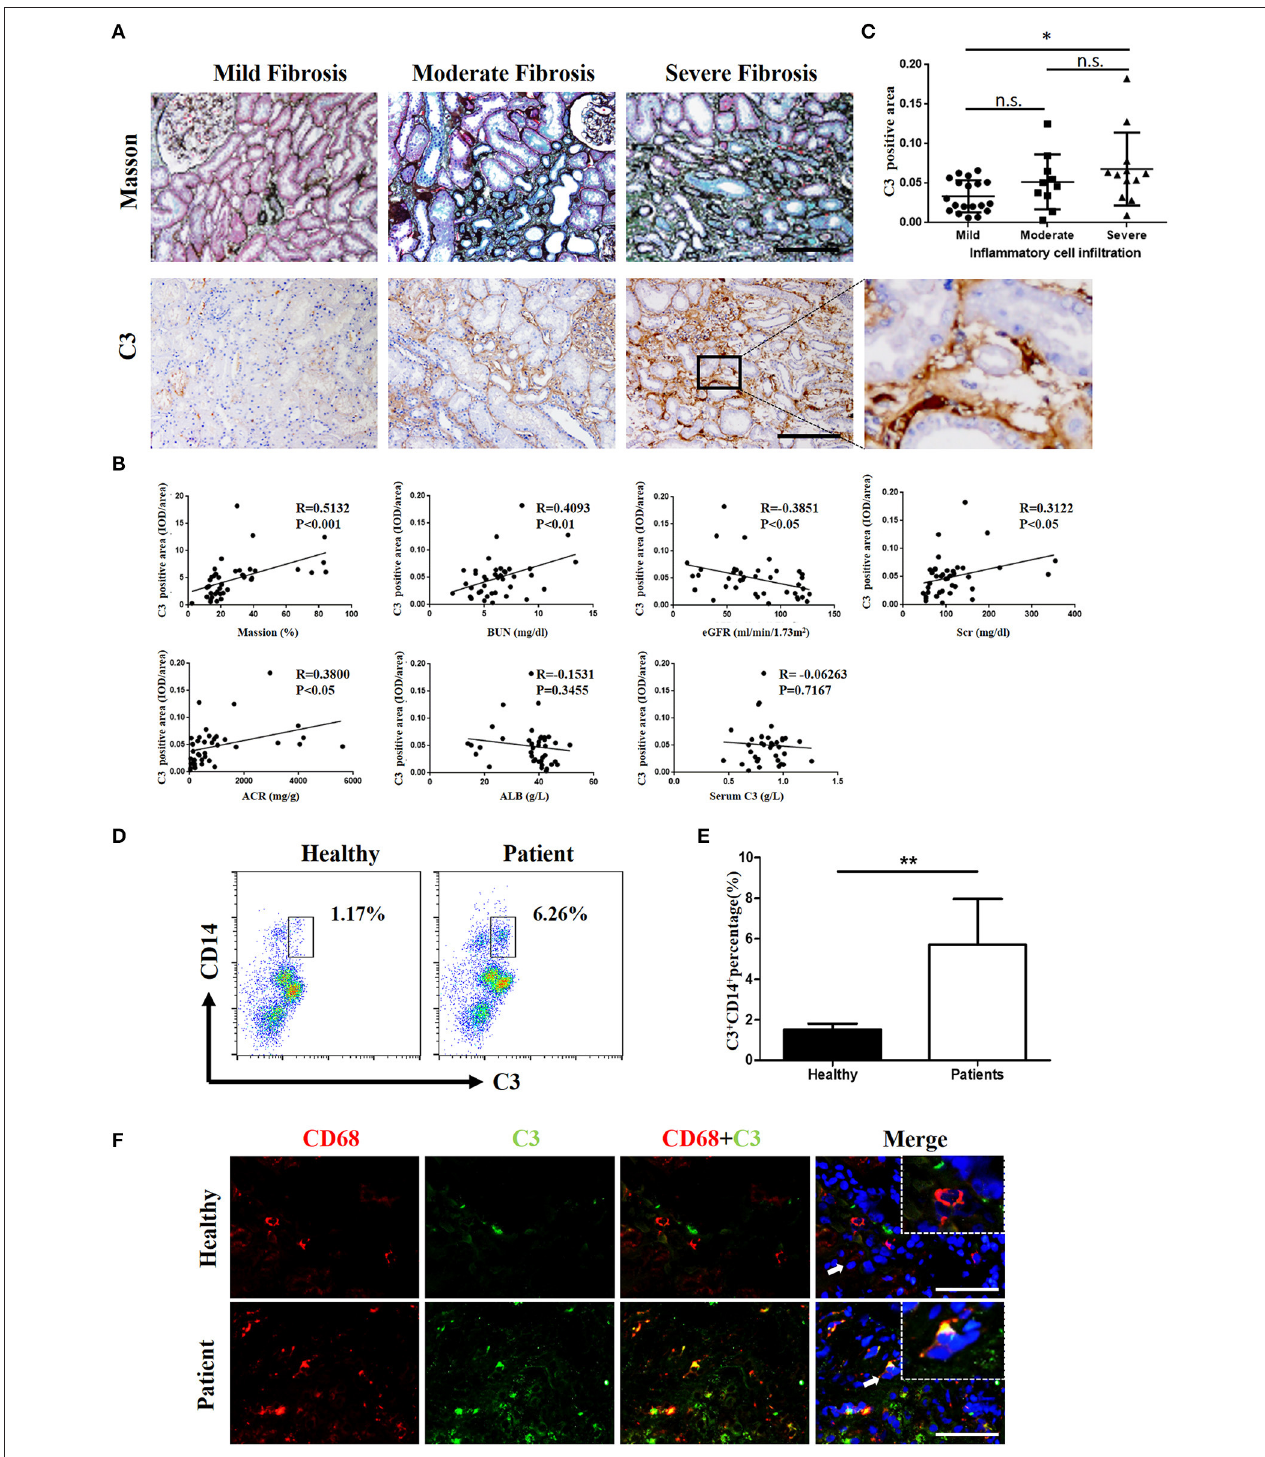
FIGURE 1 | C3 levels were increased in renal tissues and blood samples from patients with IgAN (A) Masson’s trichome staining showing collagen deposition; IHC analysis of C3 expression in the kidney. n = 41 patients with IgAN. (B) Relationships between C3 in the interstitium with Masson’s trichome staining, BUN, the eGFR, Scr, ACR, ALB, and serum C3. (C) Relationships between C3 in the interstitium with the degree of inflammatory cell infiltration. Error bars represent SEM. * P < 0.05. (D) Flow cytometric analysis showing the percentages of C3 + CD14 + in PBMC of patients with IgAN. The data shown are representatives of FACS profiles. (E) The histograms show the increased the percentages of C3 + CD14 + in peripheral blood mononuclear in the IgA patients ( n = 41) compared with the healthy ( n = 37). The error bars represent the SEM. ** P < 0.01. (F) Immunofluorescence staining of CD68 (red) and C3 (green) in the kidney. Scale bar, 50 µ m.